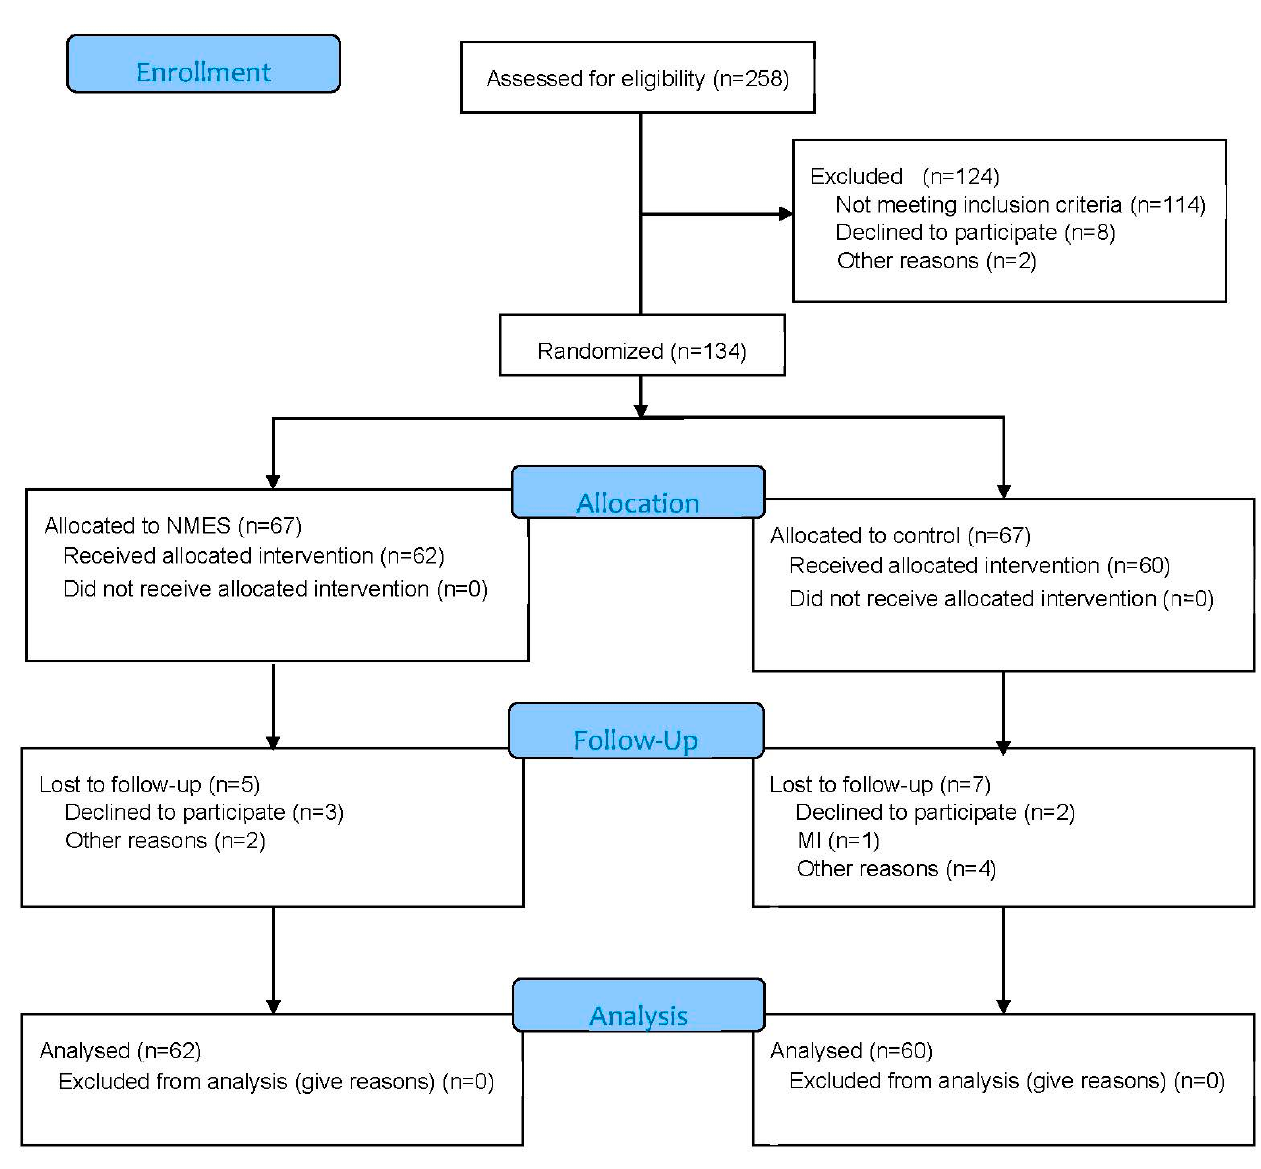
Figure 1. Flow diagram of study participants.